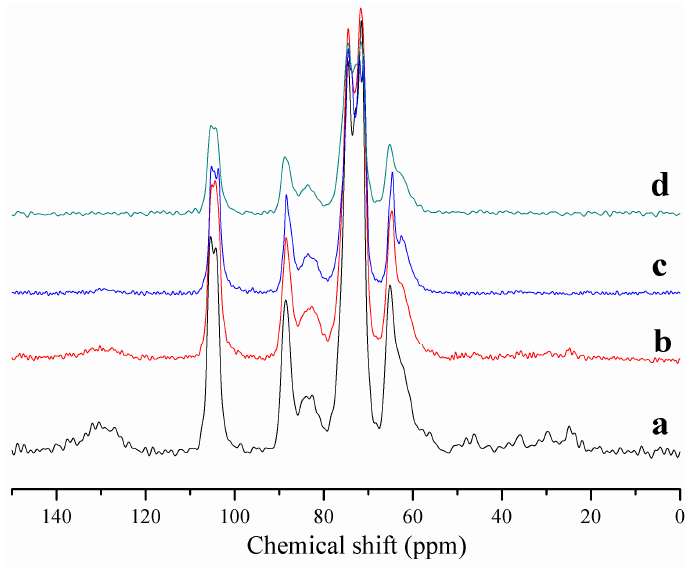
Figure 9. 13 C MAS NMR spectra of MC Pro-Phe before reaction ( a ), and recovered after 1 ( b ), 5 ( c ) and 12 ( d ) h of hydrolysis reaction using H 3 PW 12 O 40 as the catalyst. Table 4. Glucose selectivity in hydrolysis reaction of cellulose using two catalysts. Sample Reaction Time